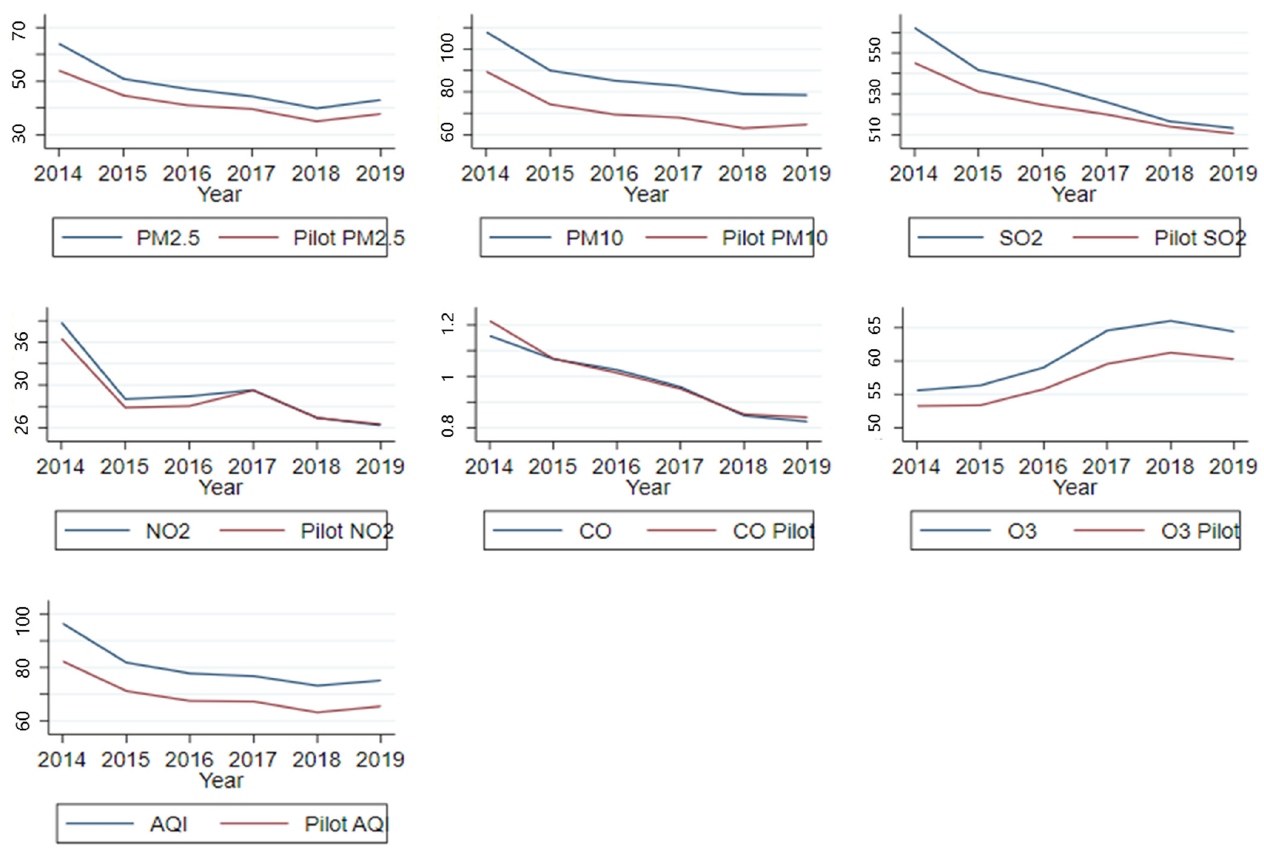
Figure 1. Air pollution trends in pilot and non-pilot cities.